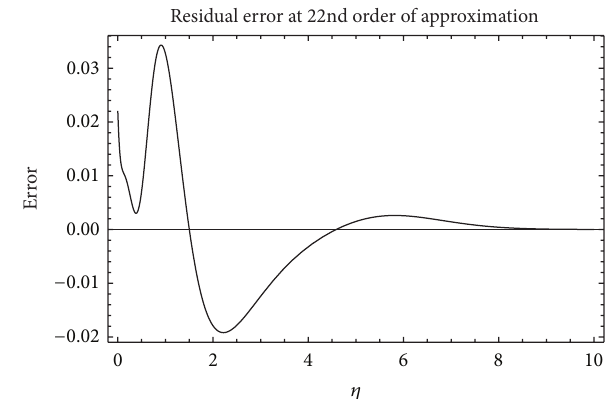
Figure 4: Effect of viscoelastic parameter 𝛼 on the velocity profile when 𝜆 = 0.2, 𝜉 = 0.5 , and 𝛽 = 5 are kept fixed.